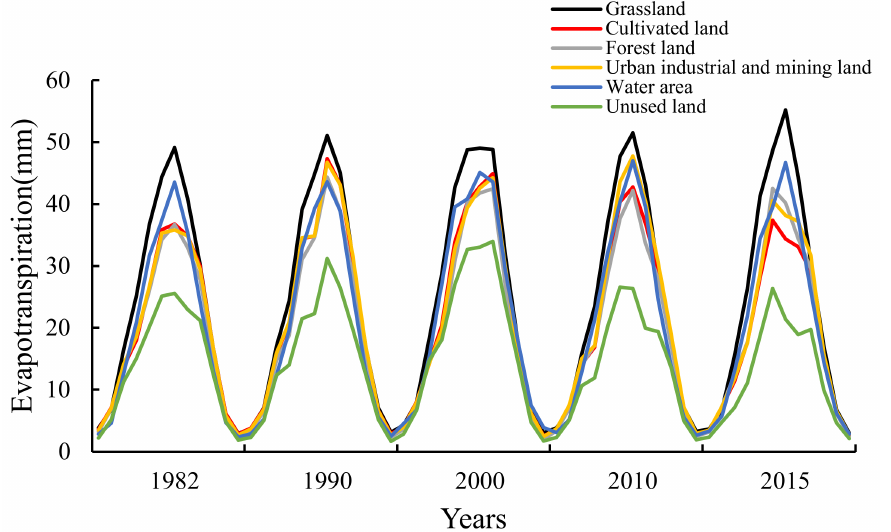
Figure 4. Change trend of monthly evapotranspiration data of different land-use types in southern